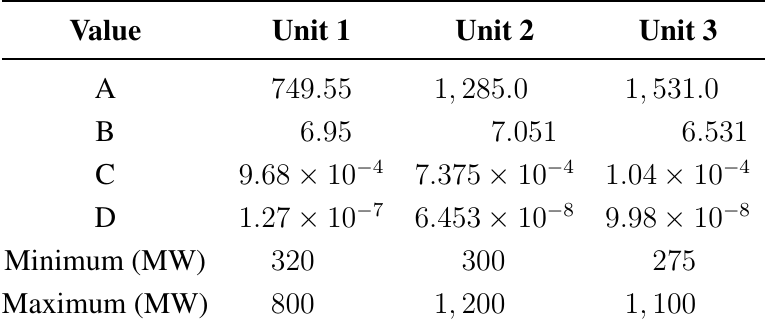
Table 4. The coefficients and boundaries for the I/O